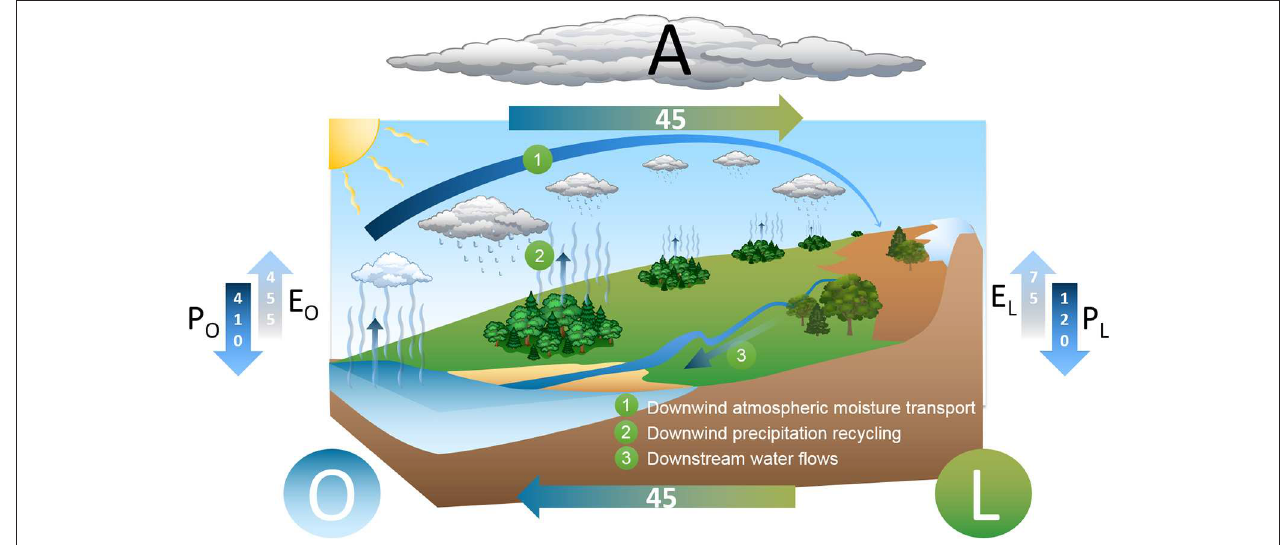
FIGURE 2 | Forest cover changes affect regional, continental and global hydrological cycles and thus downwind and downstream water resources. At the global scale, of the net oceanic evaporation flux (EO, 455,000 km 3 /year), most (410,000 km 3 /year) returns as precipitation over oceans, with the remaining (45,000 km 3 /year) contributing to precipitation over land. The net land evaporation flux (EL), made up of evaporation and evapotranspiration (75,000 km 3 /year), recycles water back to the atmosphere, thereby contributing to the oceanic component moving over land. Together, these quantities combine to form atmospheric rivers, with a net flux of PL, 120,000 km 3 /year of water falling back as precipitation over land surfaces, thereby recharging surface and ground water supplies. A net flux of 45,000 km 3 /year of land water eventually makes its way back to the ocean. These land surface water fluxes are strongly influenced by natural and anthropogenic modifications of land cover (based on global hydrologic flux data from van der Ent and Tuinenburg, 2017) (Figure modified from Ellison et al., 2017 with the permission of Elsevier).